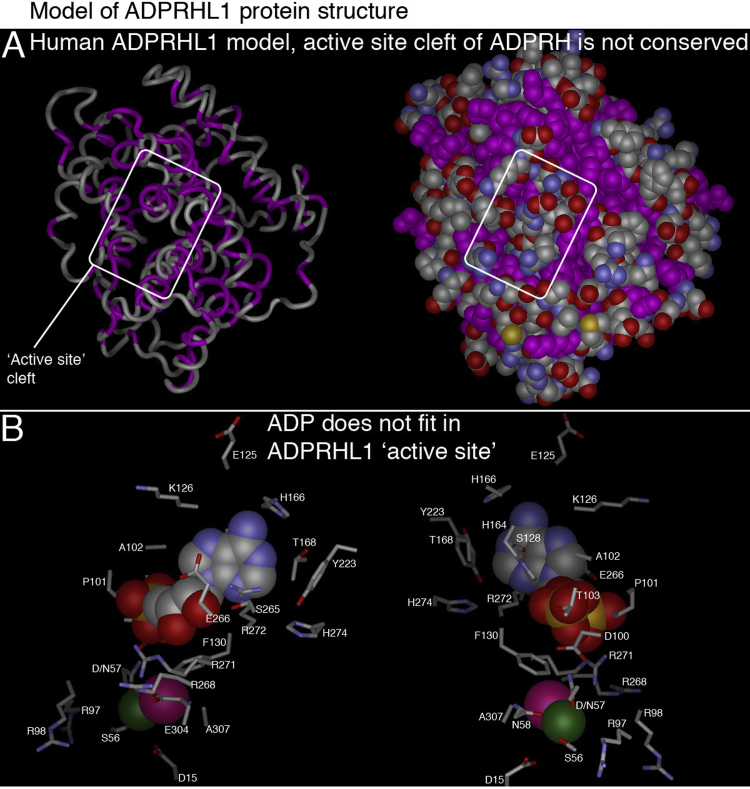
Model of ADPRHL1 protein structure. A: The sequence of human ADPRHL1, modelled onto the known structure of human ADPRH (PDB ID: 3HFW). The left panel shows the protein backbone while the right also shows the surface of amino acid side chains represented as space-filled spheres. Residues that are common to the two proteins are false-coloured magenta. The white rectangle marks the location of the active site cleft of ADPRH. The Xenopus Adprhl1 sequence produced essentially the same model. B: Detail of side chains from the active site cleft region that are conserved in ADPRHL1 proteins from all vertebrate species (coordinates used are from a model of the Xenopus sequence). Into this cleft, ADP has been forcibly inserted using the coordinates as found in ADPRH. However many side chains occlude favourable ADP binding (eg. D100, S128, F130, E304). In the left panel, the orientation of the cleft matches the view of the whole protein (A), while for the right panel, the cleft is rotated 90° around a vertical axis. The coordinates of a Mg2+ ion from structure -3HFW (green sphere) and a second (Mn2+) ion from related DRAG structure -2WOE (magenta sphere) are also depicted.